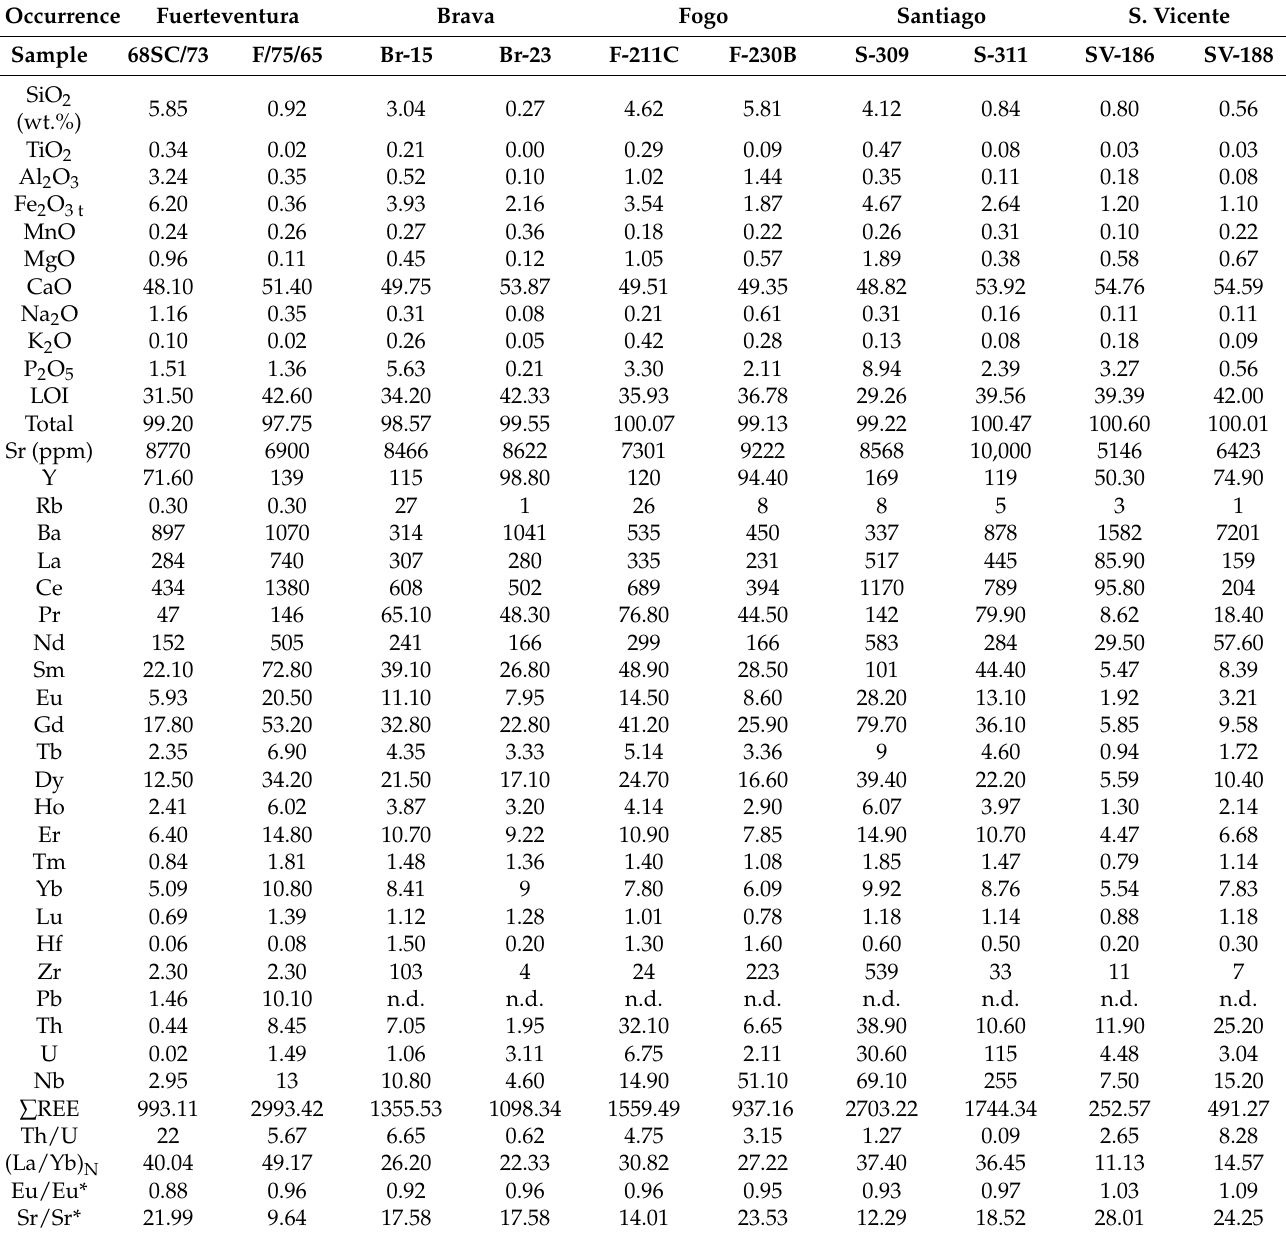
Table A1. Literature data of major and trace element compositions of Fuerteventura and Cape Verde whole-rock